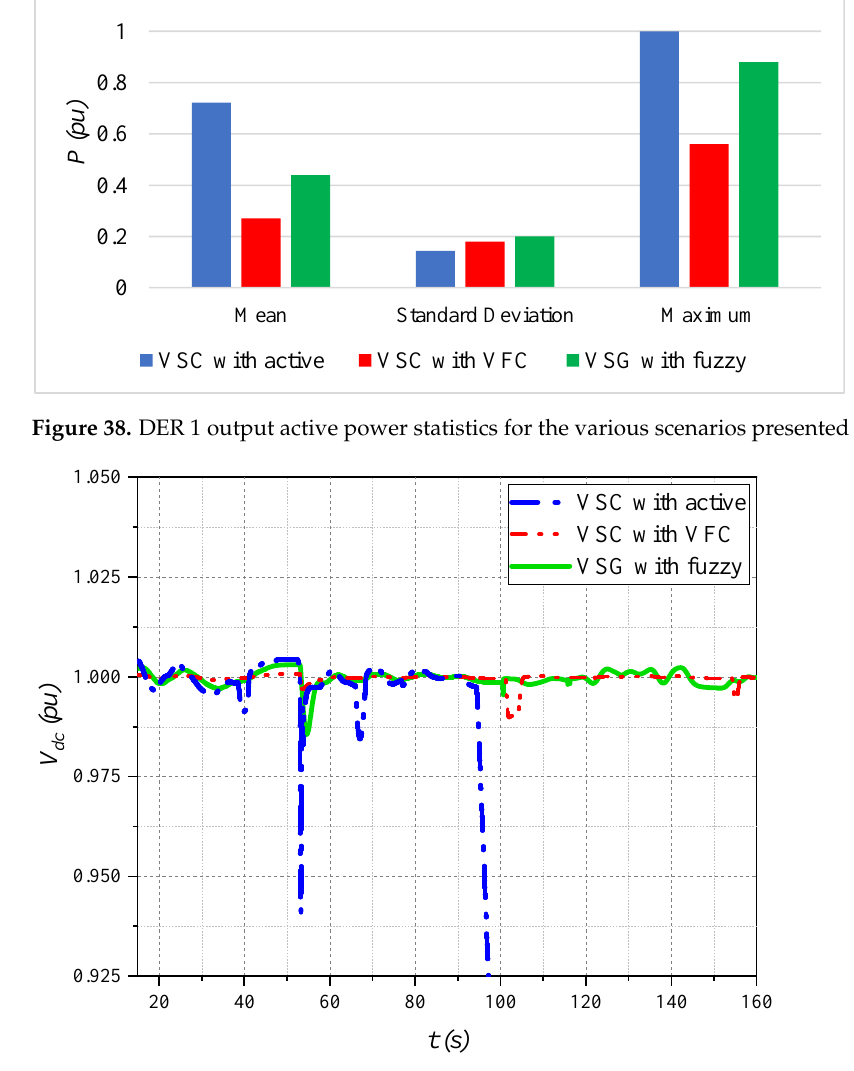
Figure 39. DC-link voltages of DER 1 for the different scenarios presented in Section 4.3.